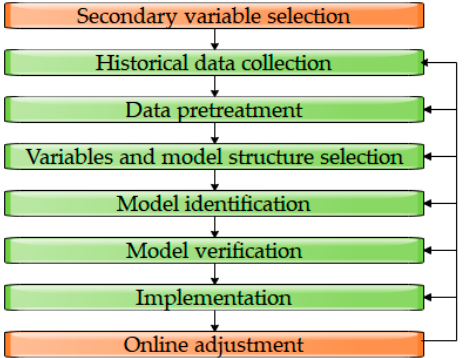
Figure 1. The typical steps of soft sensor development.